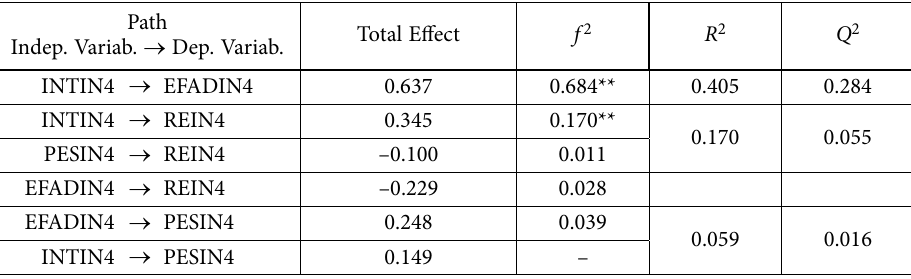
Table 13. Results of the structural model Path Indep. Variab. → Dep.